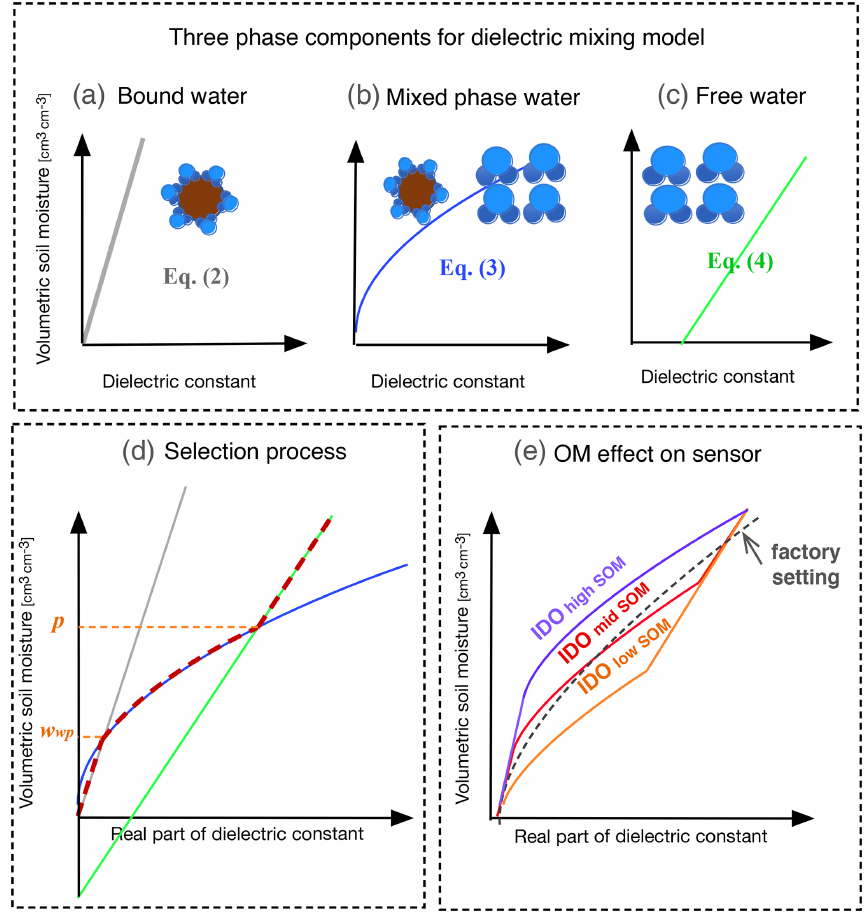
Figure 1. Single phase relationship between (a) dielectric constant and bound water, (b) bound and free water mixture, (c) free water, (d) soil moisture estimated among those models, and (e) comparison with the polynomial-based soil probe sensor algorithm proposed by Seyfried (Seyfried and Murdock, 2004) and for IDO.